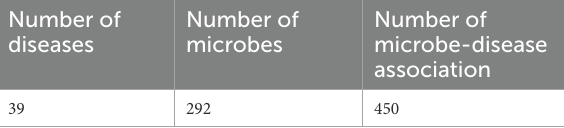
associations. The heterogeneous network contains two node types: microbe nodes and disease nodes, and three types of connecting edges: microbe connecting edges, disease connecting edges, and